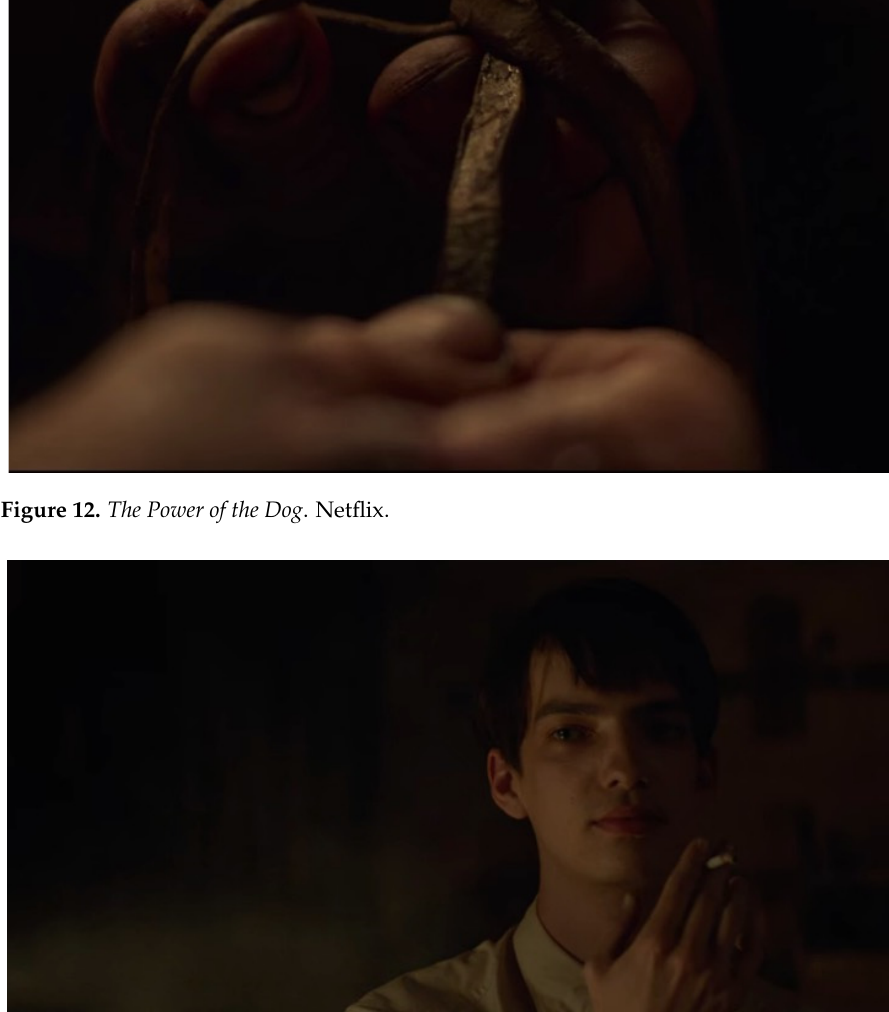
Figure 13. The Power of the Dog . Netflix.